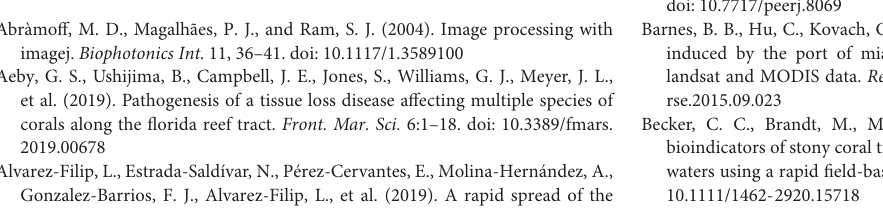
Supplementary Figure 3 | Logistic regression of health condition on symbiont-to-vacuole ratio for Orbicella faveolata . Dashed lines denote where model has 50% accuracy in predicting health condition. Test statistics indicate results of one-way binomial regression analysis, and error bars denote standard error of the mean. Treatment abbreviations as in Table 1 . Treatment colors as in Figure 1 , except for healthy sediment (HS) shown as gray to distinguish from disease contact (DC). Supplementary Figure 4 | Boxplots of symbiont-to-vacuole ratio, proportion of exocytosis, and gastrodermal separation in each treatment for each species. Test statistics indicate results of two-way beta regressions, and asterisks denote significant differences in treatments relative to healthy controls following a one-way beta regression for each species ( p < 0.05). Error bars indicate standard error of the mean. Treatment abbreviations as in Table 1 . Treatment colors as in Figure 1 , except for healthy sediment (HS) shown as gray to distinguish from disease contact (DC). Supplementary Table 1 | Test statistics for comparisons of variation in microbial communities among species, treatments, and coral conditions. Non-significant p -values denoted as ns. Treatment abbreviations for post hoc comparisons as in Table 1 . Supplementary Table 2 | Differentially abundant ASVs identified across sediment samples by coral condition and the individually-inoculated sediment (IDS) treatment in our experiment. ASVs are organized by alphabetical taxonomy, and association with tissue loss/IDS samples denoted with ‘yes.’ Supplementary Dataset 1 | Dataset of time to lesion and transmission rate data across species and disease treatments, including general transmission signs. Transmission symptom definitions: mesenterial filaments (MF), mucus production (Mucus), liquefactive necrosis (Necrosis), tissue paling/bleaching (Paling), tissue swelling (Swelling), and tissue loss (TL). Supplementary Dataset 2 | Dataset of histological measurements across species and disease treatments, including symbiont-to-vacuole ratio (Zooxarea), proportion of symbiont cells exocytosed (Exopercent), and gastrodermal separation distance (Gastrosep). Supplementary Dataset 3 | Dataset of ASVs identified in sediment samples, including taxonomic assignments and relative abundance across samples. Sample IDs as in Supplementary Dataset 1